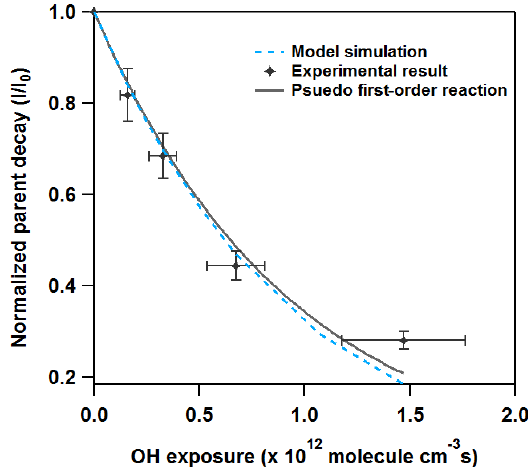
Figure 4. Normalized parent compound decay from experimental results and model